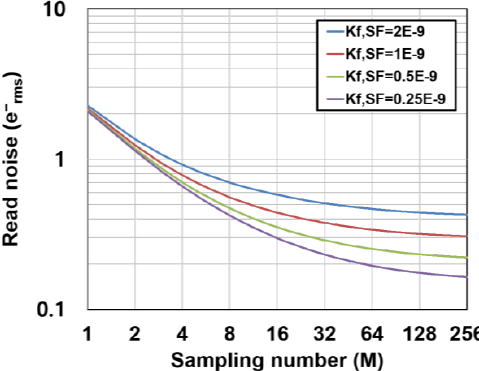
Figure 10. Calculated total read noise as a function of M and for different values of K f, SF . Table 1. Device and circuit parameters used for noise calculations.